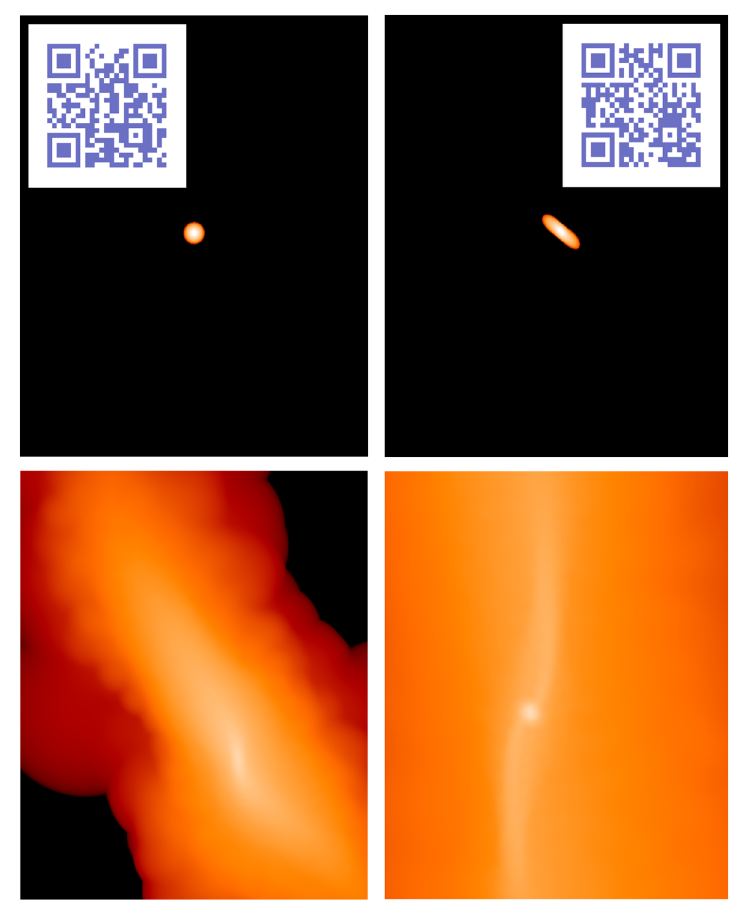
Fig. 2 Four snapshots in the evolution of a tidal disruption of a star. In this simulation, which I have done with GADGET-2 (Springel 2005), the star is modelled as a polytrope using 5 · 10 4 particles. The penetration factor, which is defined to be the ratio between the tidal radius and the distance of periapsis, has been set to 9. The mass of the MBH is 10 6 M (cid:2) and of the star 1 M (cid:2) . The snapshots correspond to the initial time, and three later moments in the evolution. The left and right quick response codes link to two movies in the frame of the star and the general one, which point to the URLs https://youtu.be/Ryc44v4Eb7I and https:// youtu.be/uZqXBD8R9Dw,